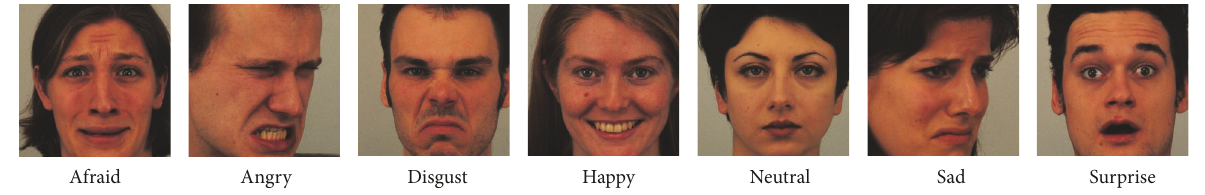
Figure 5: Sample images from each class of KDEF dataset. Table 1: Description of the test movies data.